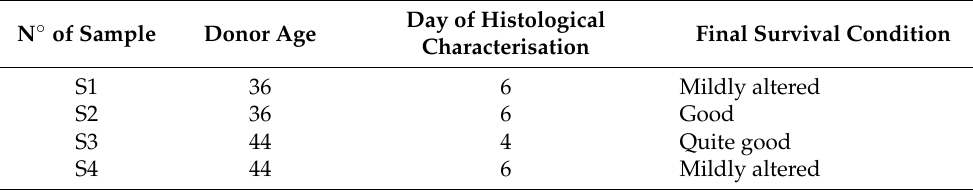
Table 2. Donor information and final survival condition of the 4 stripped skin explants. S1 and S2 were from female donors of phototype 5 while S3 and S4 were from ones of phototype 1–2. N ◦ of